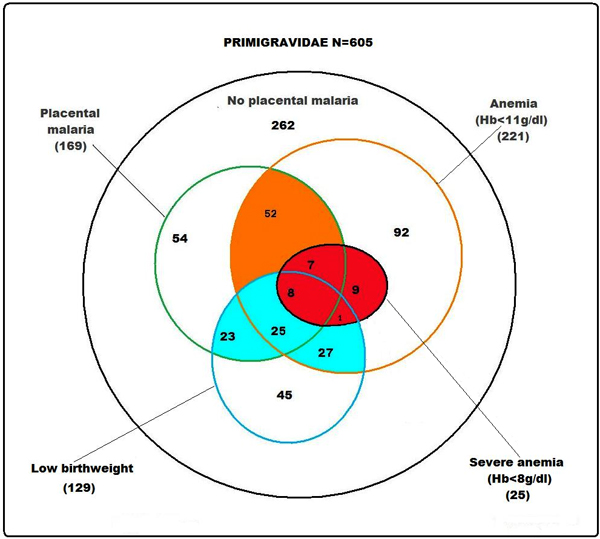
Venn diagram for malaria related pregnancy outcomes in 605 primigravidae. Data source: DELIMAL study, Burkina Faso (S. Gies et al, unpublished data and [34]).